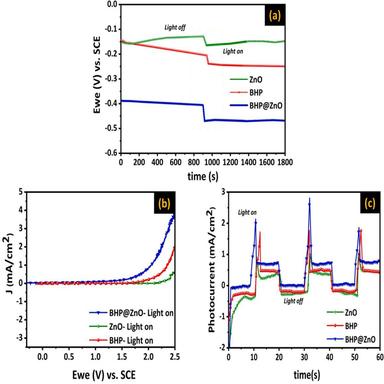
(a) Open circuit potential (OCP) of ZnO, BHP and BHP@ZnO in darkness and under irradiation, (b) linear sweep voltammetry under irradiation, (c) Photocurrent measurement of the synthesized materials.